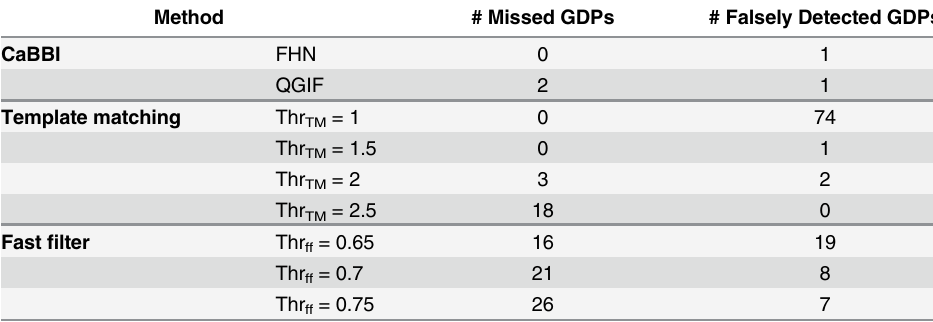
Table 4. GDP detection results of three different methods (first data set). Method # Missed GDPs # Falsely Detected GDPs